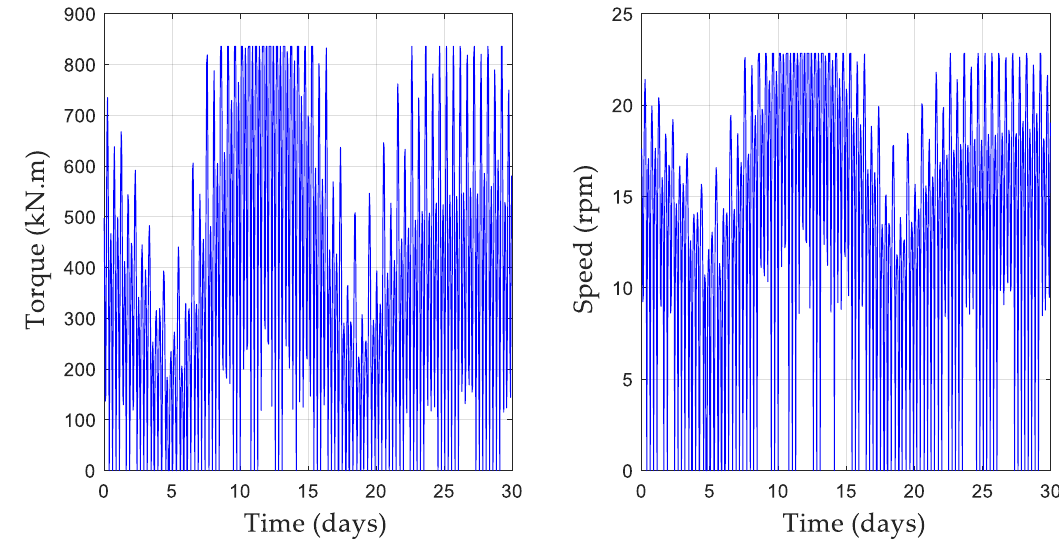
Figure 8. Torque and speed profiles (after reproduction from [39]).